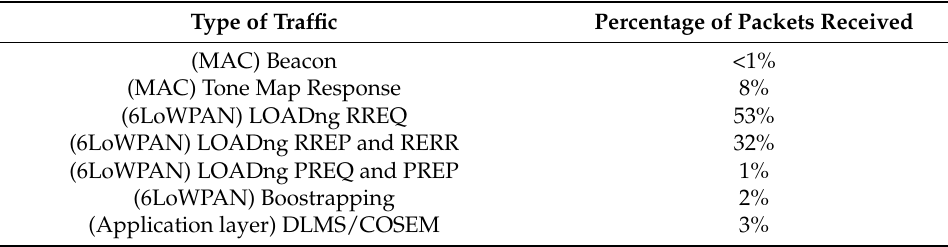
Table 1. Percentage of packets received for each traffic